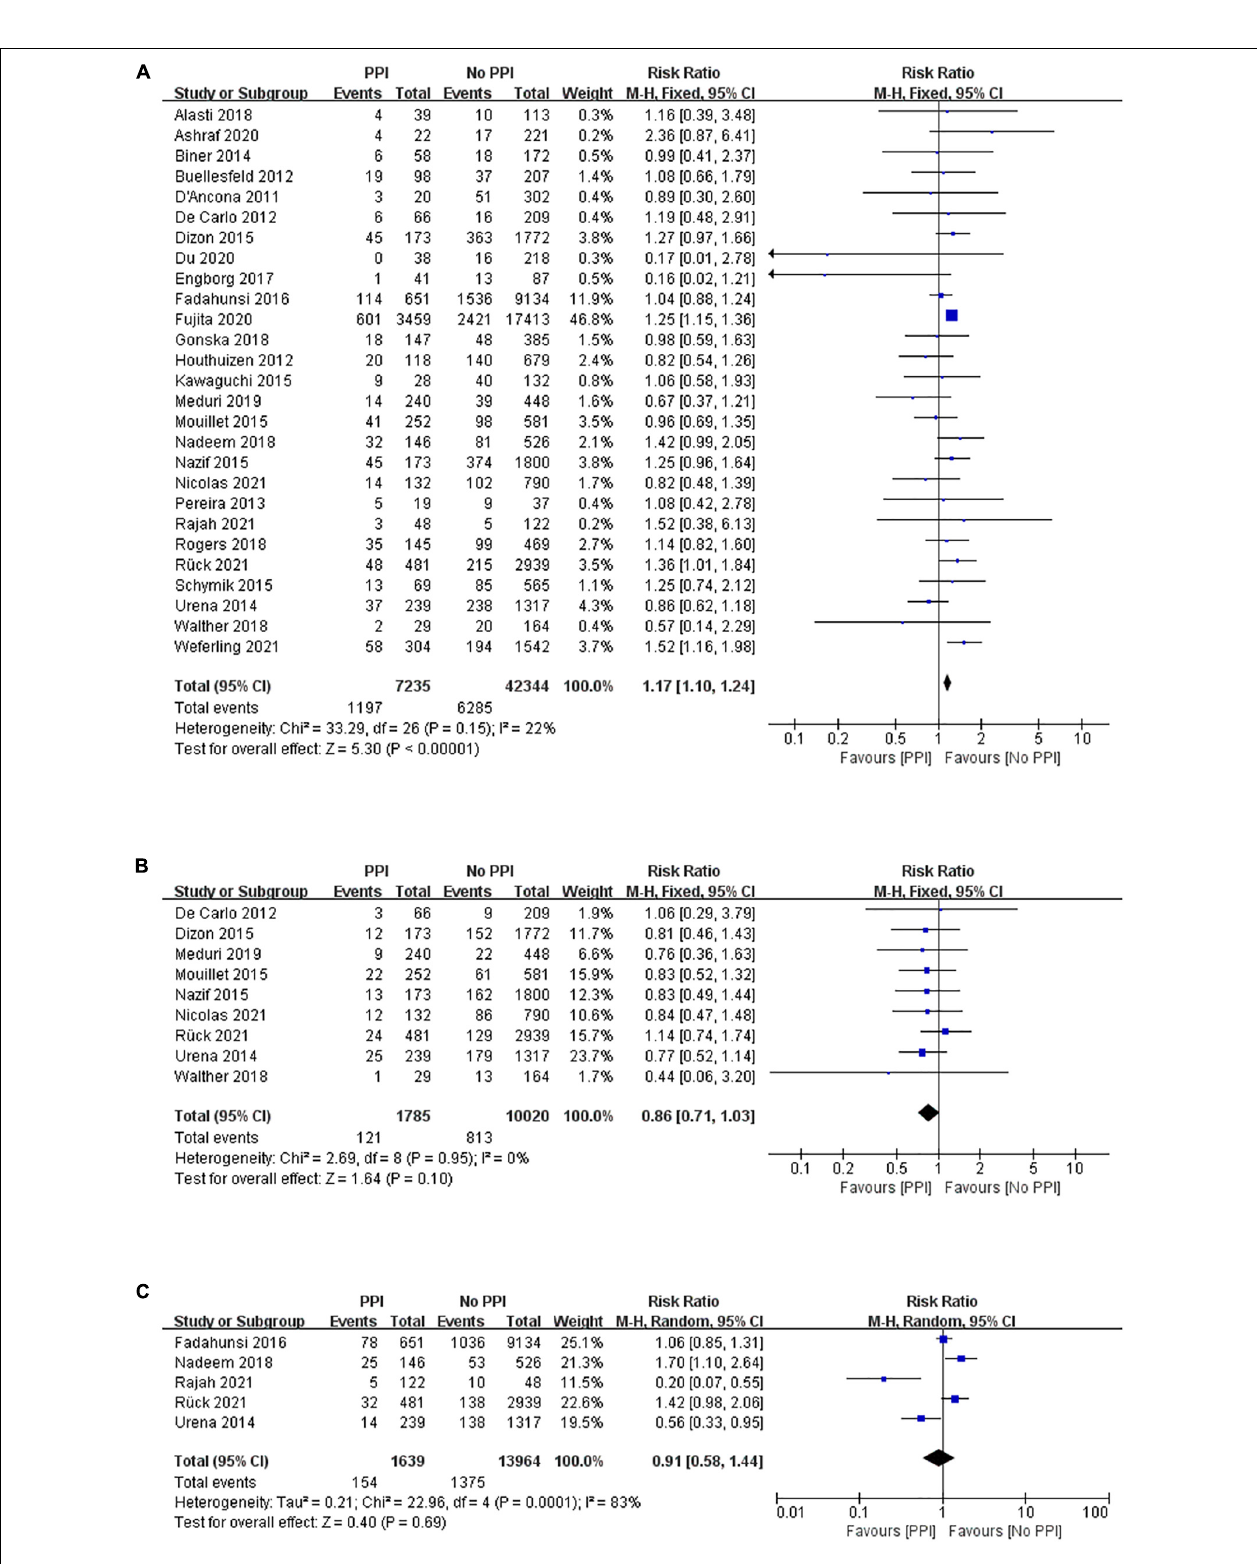
FIGURE 2 | Forest plot of the risk of mid-term (1 year) (A) all-cause mortality, (B) cardiovascular mortality, and (C) heart failure rehospitalization in patients with post-procedural permanent pacemaker implantation (PPI) after transcatheter aortic valve replacement (TAVR).